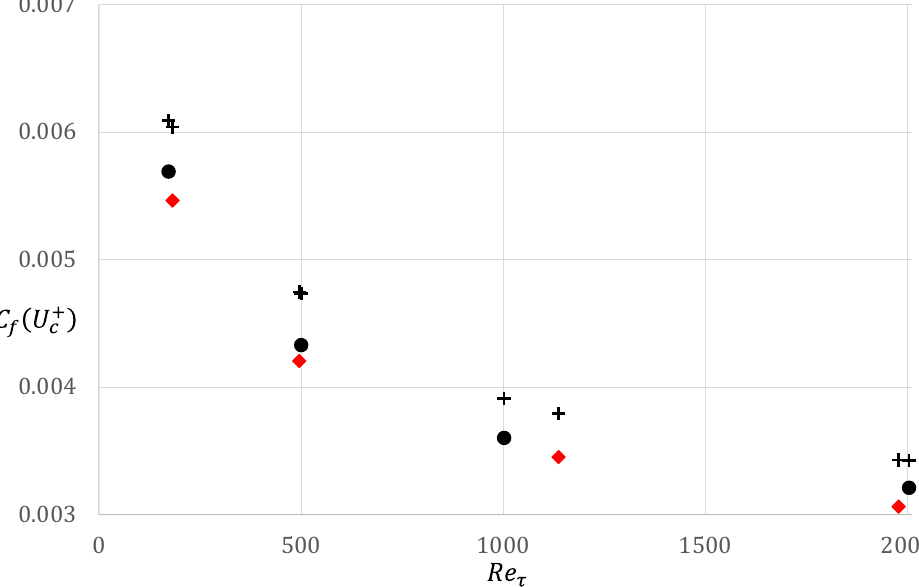
(cid:0) (cid:1) U c + ; • pipe DNS data [26]; (cid:7) pipe DNS data [31,32]; and + ; • pipe DNS data [26]; 𝑐𝑐+ 𝐶𝐶 𝑓𝑓 �𝑈𝑈 �